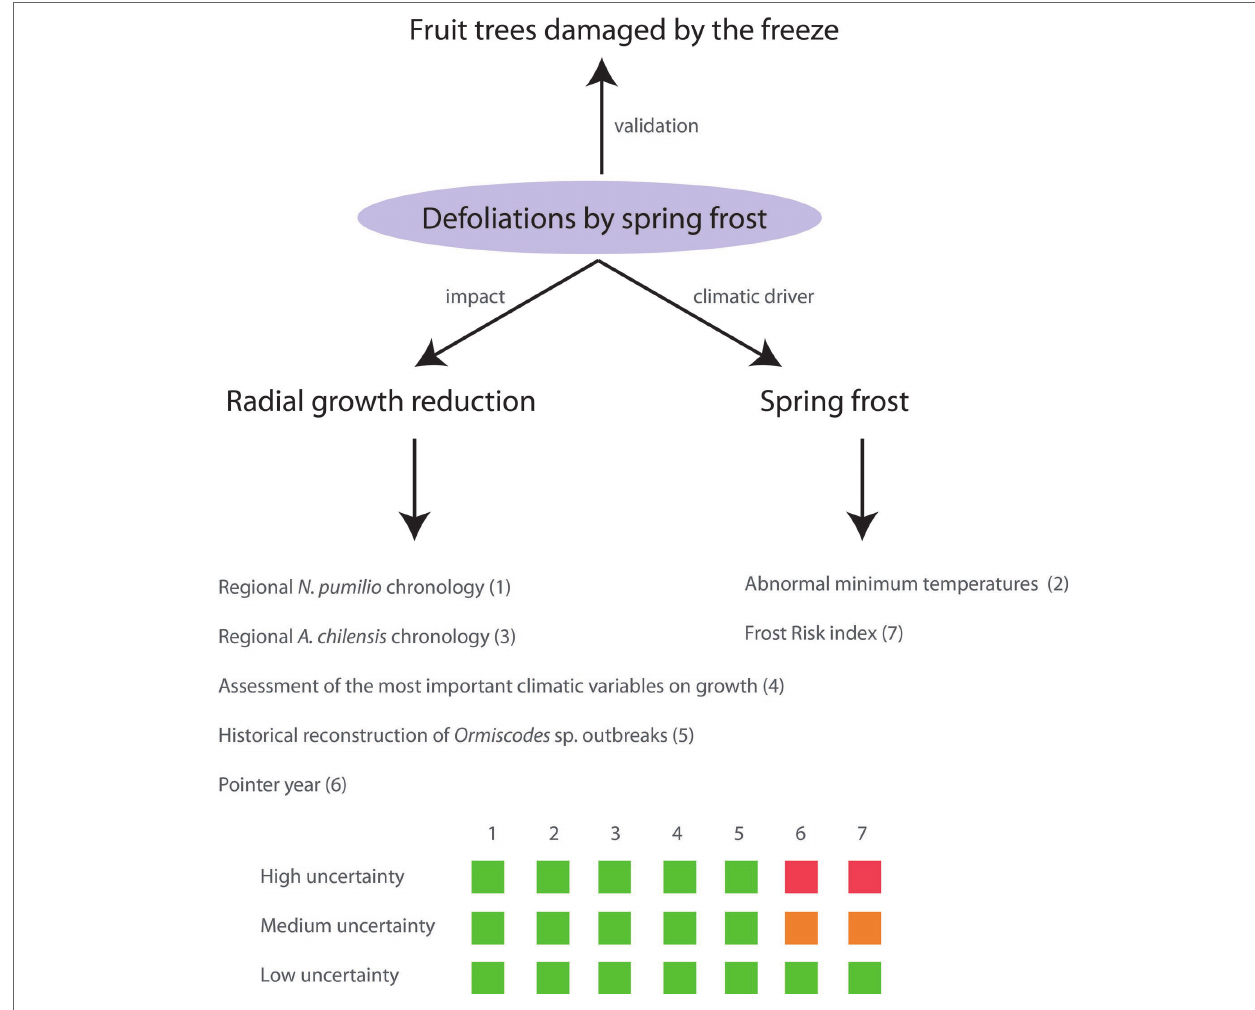
FIGURe 2 | Conceptual framework for identifying years with frost damages in N. pumilio . The confidence levels (low, medium, and high uncertainty) were displayed by squares of three colours. Green indicates the necessity to meet those criteria. Orange indicates that one out of the two additional criteria should be met. Red indicates that this criterion is not required. For more details on different methods see the corresponding section below